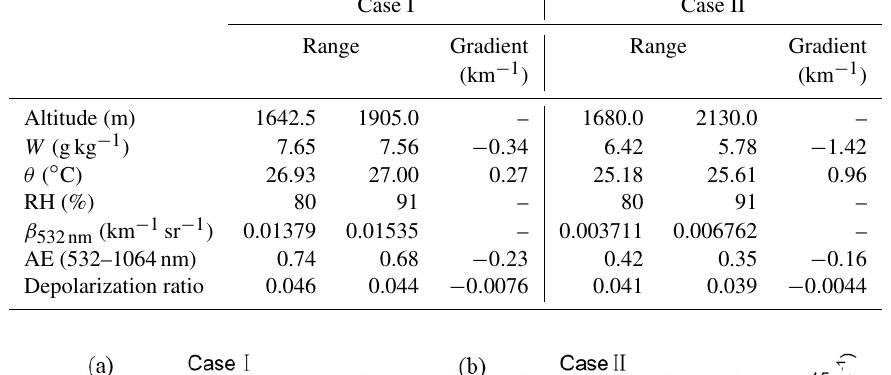
Table 2. Range of values and gradient values over the analyzed layer for the water vapor mixing ratio ( W ), the potential temperature ( θ ), the backscattering coefficient at 532nm ( β 532 ), the Ångström exponent (AE, (532–1064nm)), and the depolarization ratio at 532nm for Case I and II.